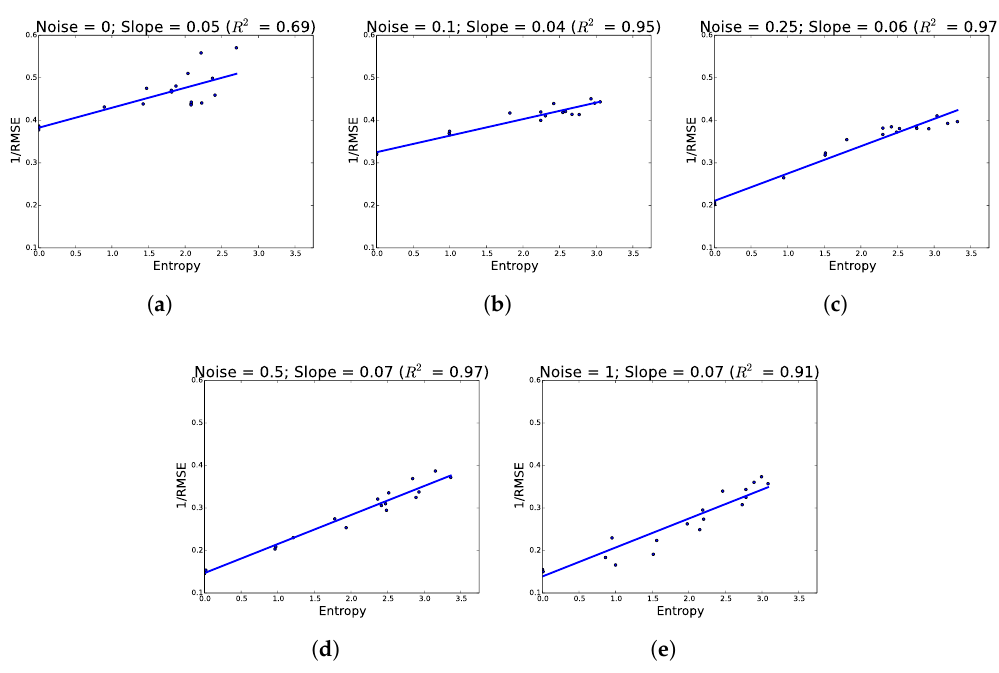
Figure 3. Performance as a function of the entropy of the hypothesis distributions on the test set. For all noise levels, higher entropy corresponds to higher network performance. ( a ) no noise; ( b ) noise = 0.1; ( c ) noise = 0.25; ( d ) noise = 0.5; ( e ) Noise = 1.